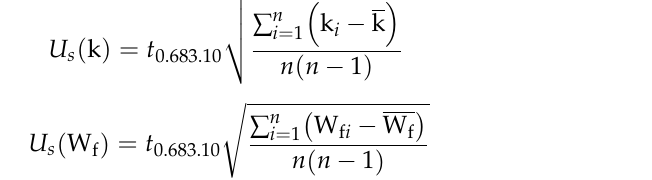
The standard uncertainty of the mean value k and Wf was determined on the basis of the standard deviation from the average value, taking into account the critical coef- ficient t0.683.10 = 1.059 determined for the confidence interval of 68.3% for a series of 10